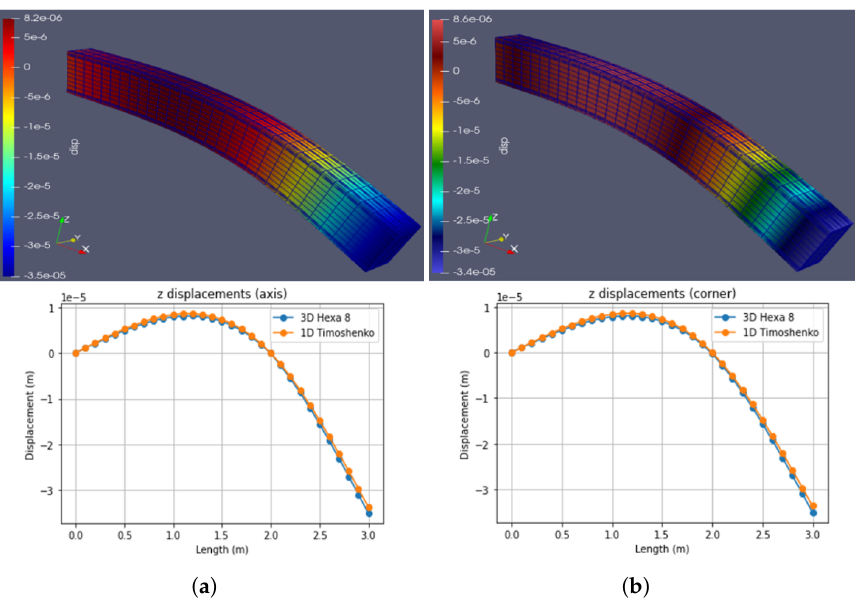
Figure 15. Case 2: At L = 3 m, Fz = − 1000 N. ( a ) Hexa8. ( b ) Timoshenko. (Note: e − n indicates 10 − n ).